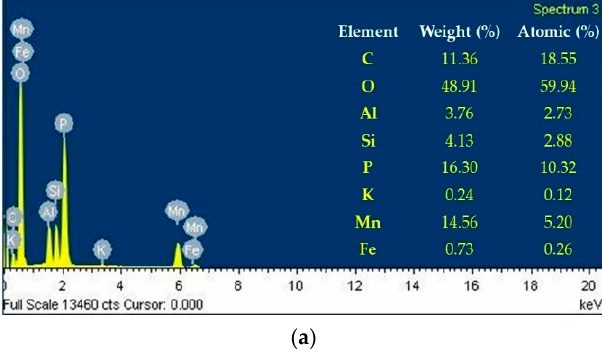
Figure 4. SEM images of the MV pigment: ( a ) Room temperature; ( b ) 410 ° C.